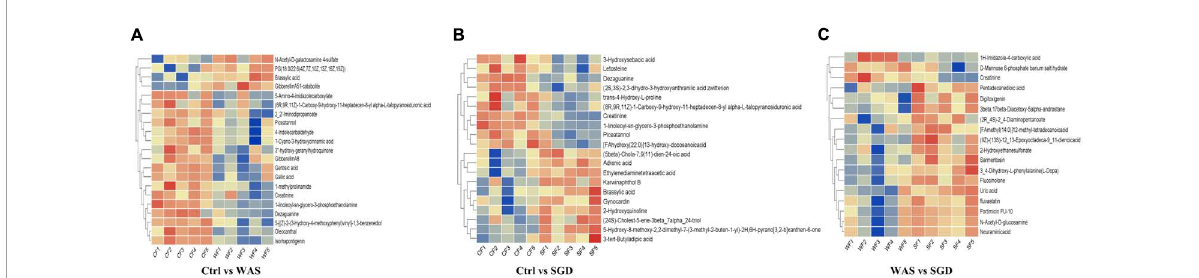
FIGURE8 Metabolic profiling: hierarchical clustering results. (A) Significantly different metabolites between control group and WAS group. (B) Significantly different metabolites between control group and SGD group. (C) Significantly different metabolites between WAS group and SGD group. The abscissa represents different samples, and the ordinate represents significantly different metabolites.